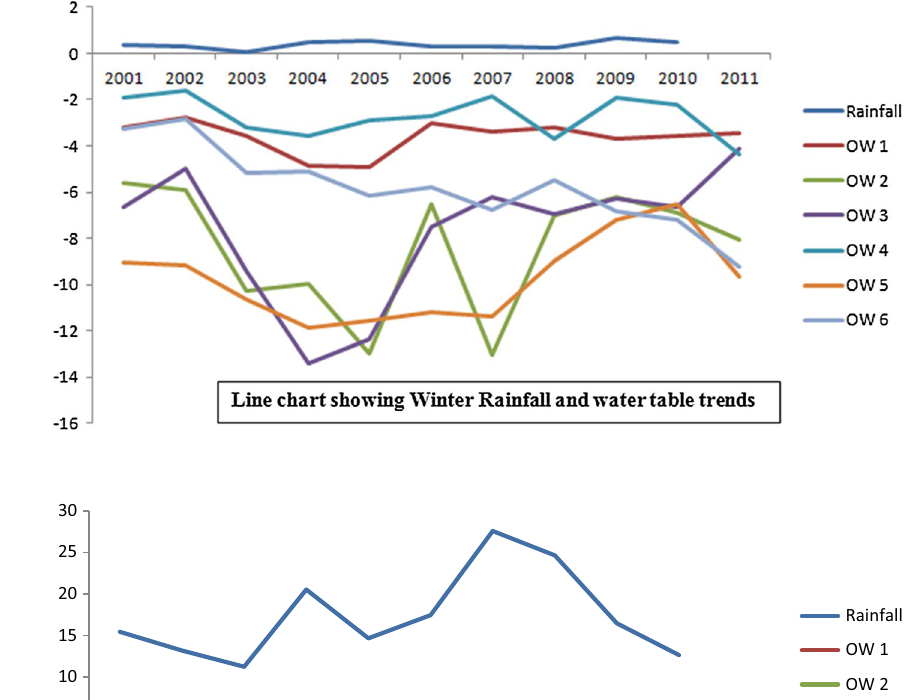
Fig. 6 Line chart representing winter rainfall and water-table trends